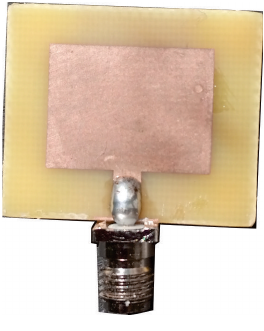
FIGURE 14. Top view of the fabricated HGWMPA.